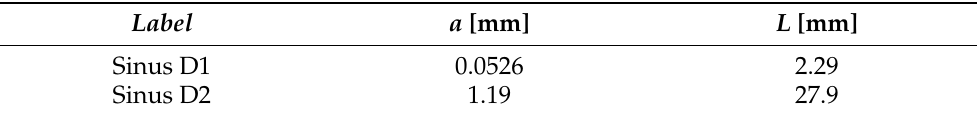
Table 2. Values of wavelength and amplitude for the sine function used for defining fiber waviness (Equation 3.1 [38]).